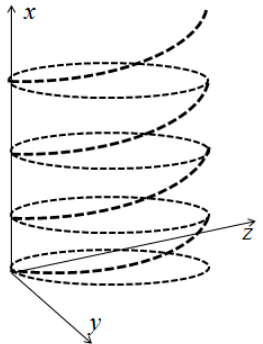
Figure 1. One of the helix-geodesics (32)–(35).